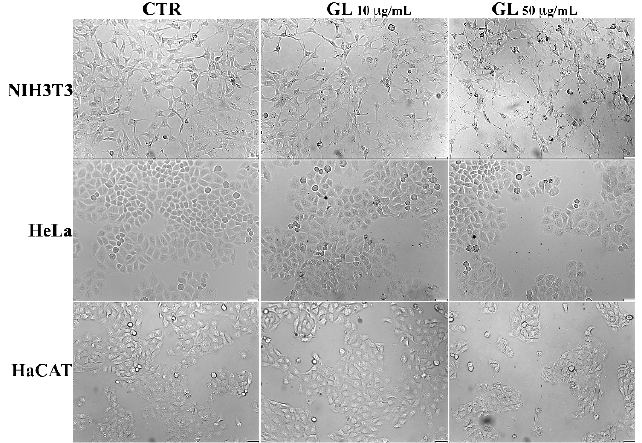
Figure 6. Representative images of morphology of cell monolayers untreated (CTR), ( left ) panels) compared to cells treated for 48 h with GL at 10 ( central ) panels) and 50 μ g/mL ( right ) panels). Scale compared to cells treated for 48 h with GL at 10 (( central ) panels) and 50 µ g/mL (( right ) panels). bar 50 μ m. Scale bar 50 µ